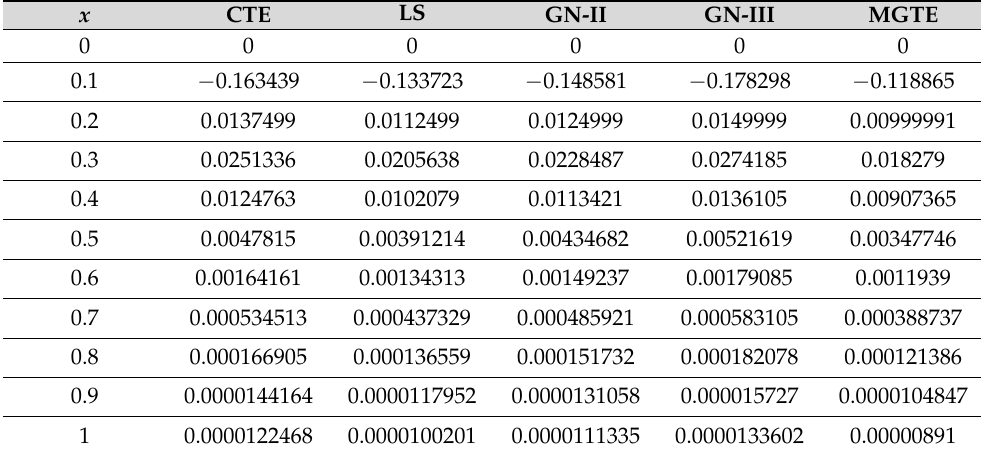
Table 5. The axial thermal stress σ xx versus thermoelastic